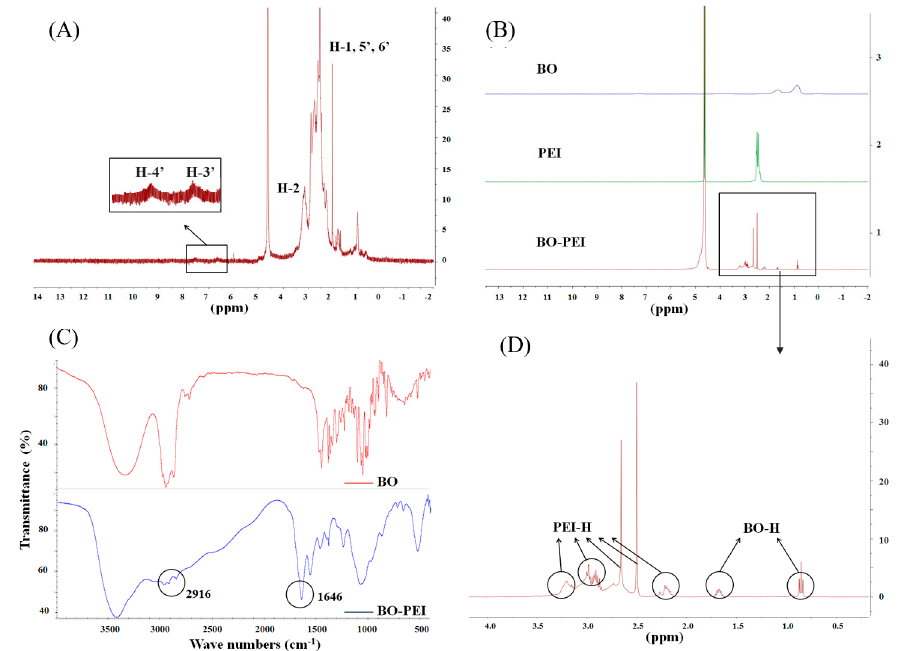
Figure 1. ( A ) Characterization of polyethyleneimine–folic acid (FA-PEI) copolymer by 1 H-NMR; ( B , D ) characterization of polyethyleneimine–borneol (BO-PEI) copolymer through 1 H-NMR spectroscopy; ( C ) characterization of BO-PEI copolymer through FTIR.